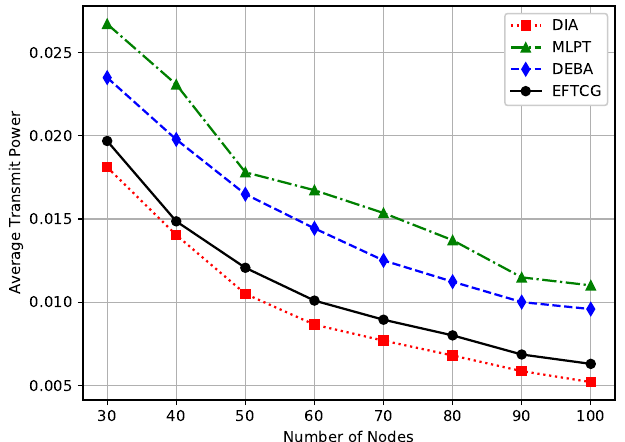
Figure 6. The comparison of the average transmit power under different algorithms.